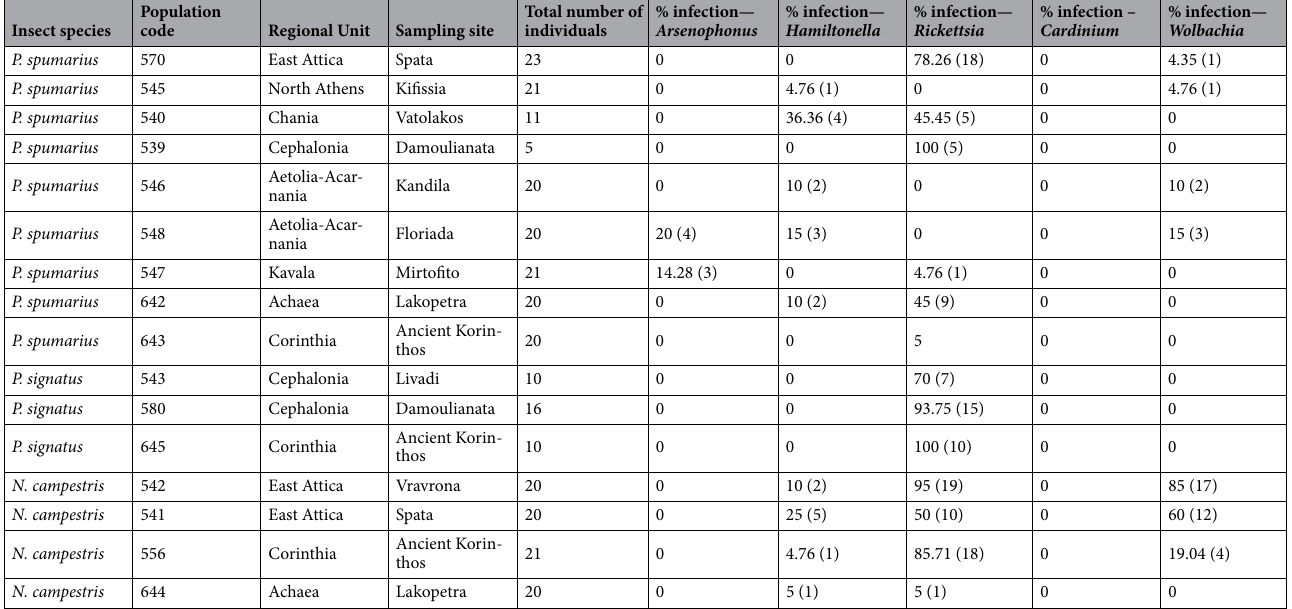
Table 2. Percentages of specimens within each population for the three insect species infected with secondary endosymbionts ( Arsenophonus , Halmitonella , Rickettsia , Cardinium and Wolbachia ). The number in the parentheses indicates the number of individuals found harboring the corresponding